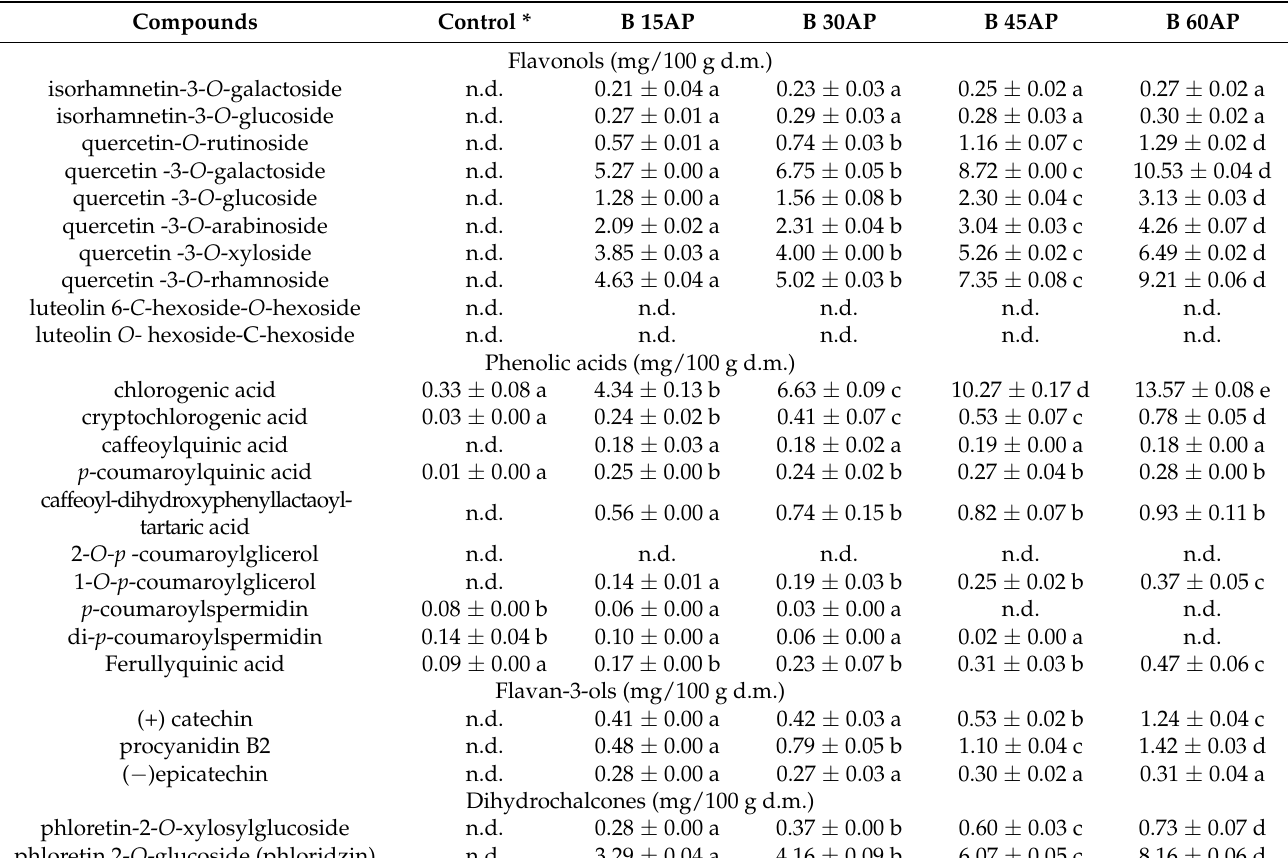
Table 3. Quantity of phenolic compounds (mg/100 g d.m.) in gluten-free cookies with apple pomace ( n = 2).